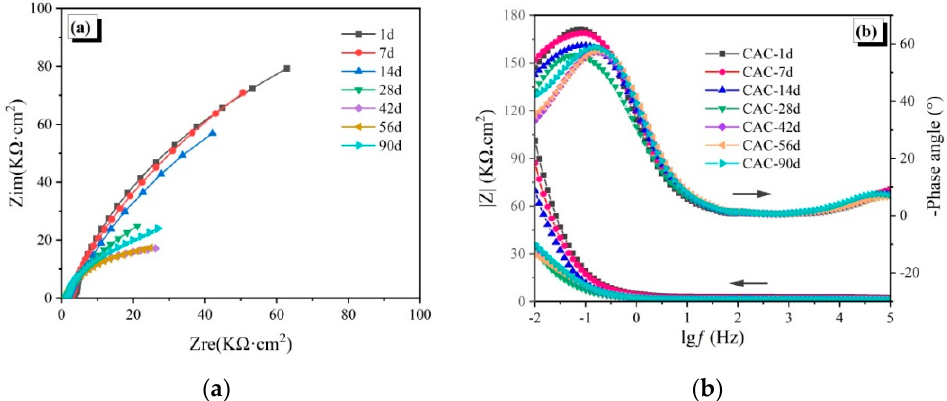
Figure 3. Electrochemical impedance spectroscopy of the CAC specimens: ( a ) Nyquist curves, ( b ) Bode curves.